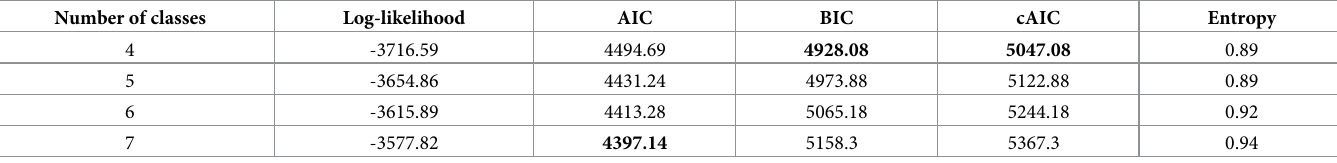
Table 2. Comparisons of model fit indices for fitted LCA models.